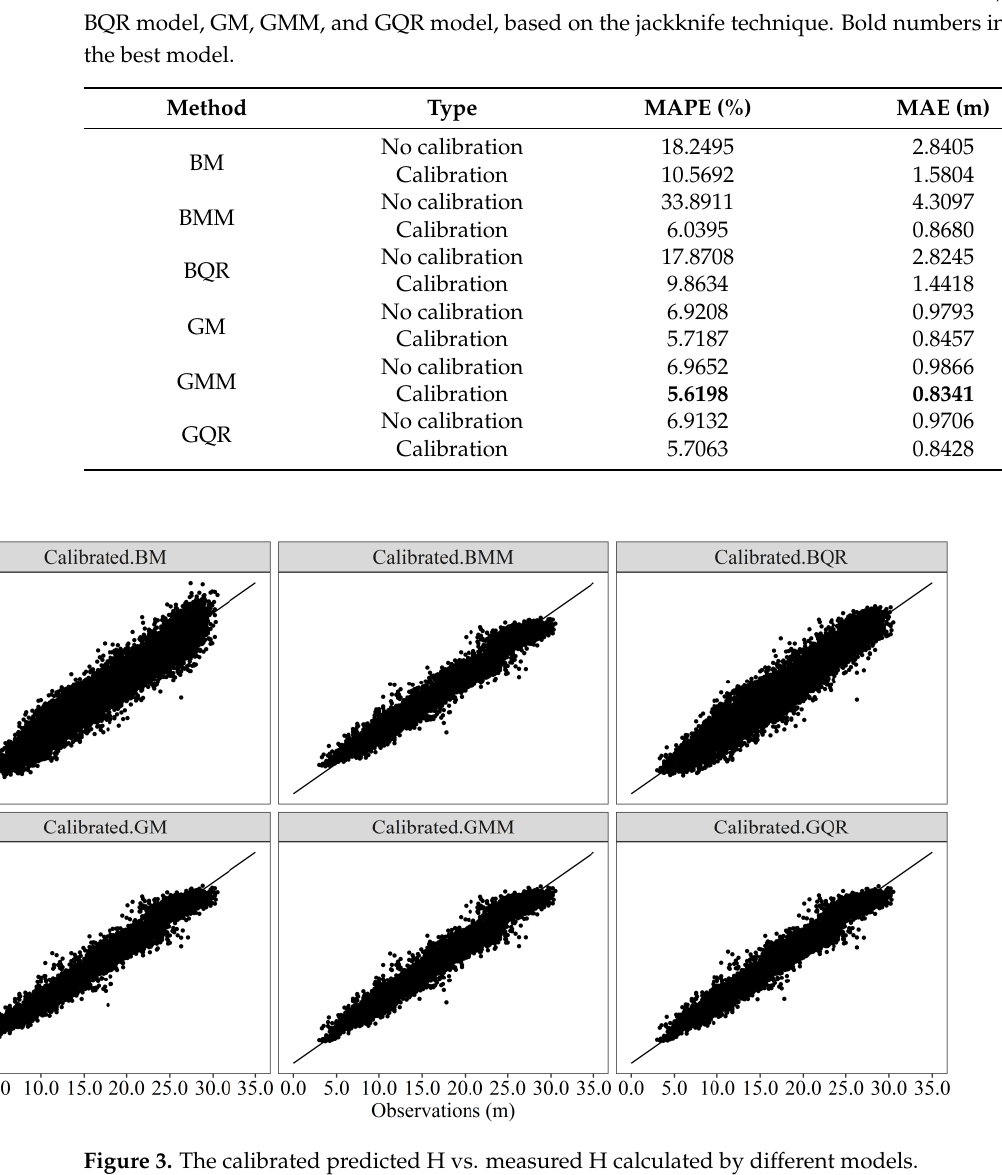
Figure 3. The calibrated predicted H vs. measured H calculated by different models.